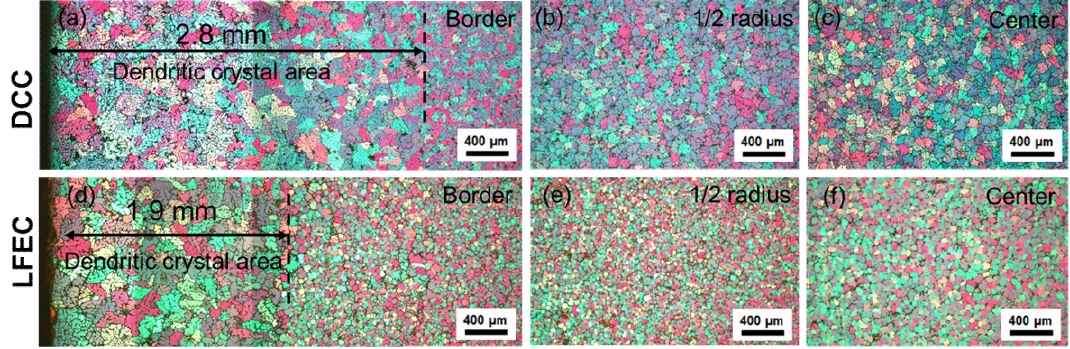
Figure 2. Micro-structure from border to center of as-cast 5A90 ingots: ( a – c ) direct chill casting (DCC) ingot; ( d – f ) low-frequency electromagnetic casting (LFEC) ingot.